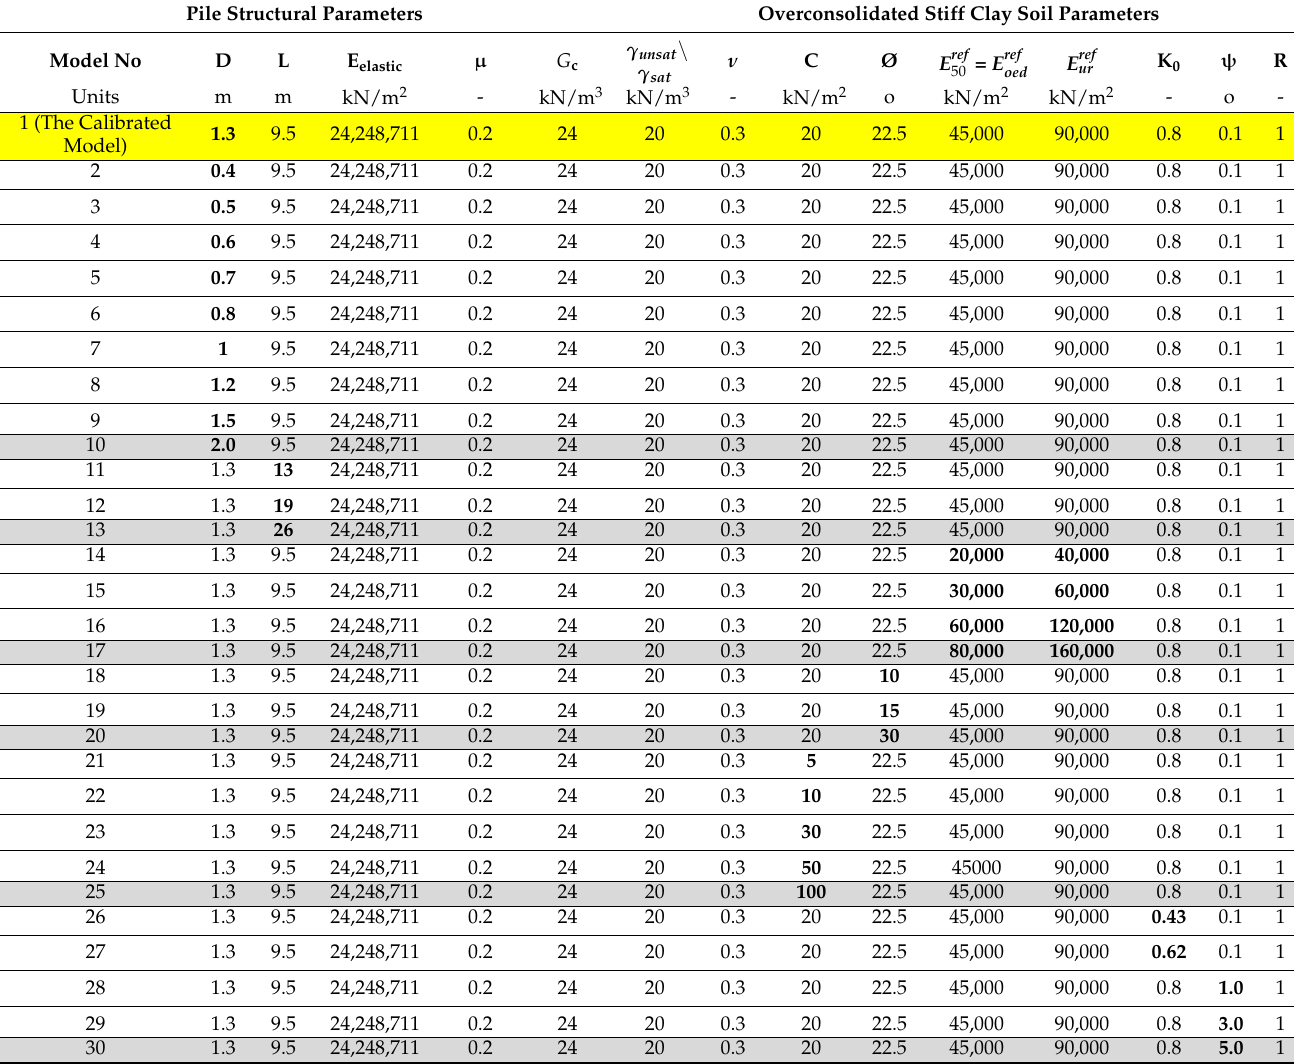
Table 1. The adopted geometrical and geotechnical parameters in the parametric study. Pile Structural